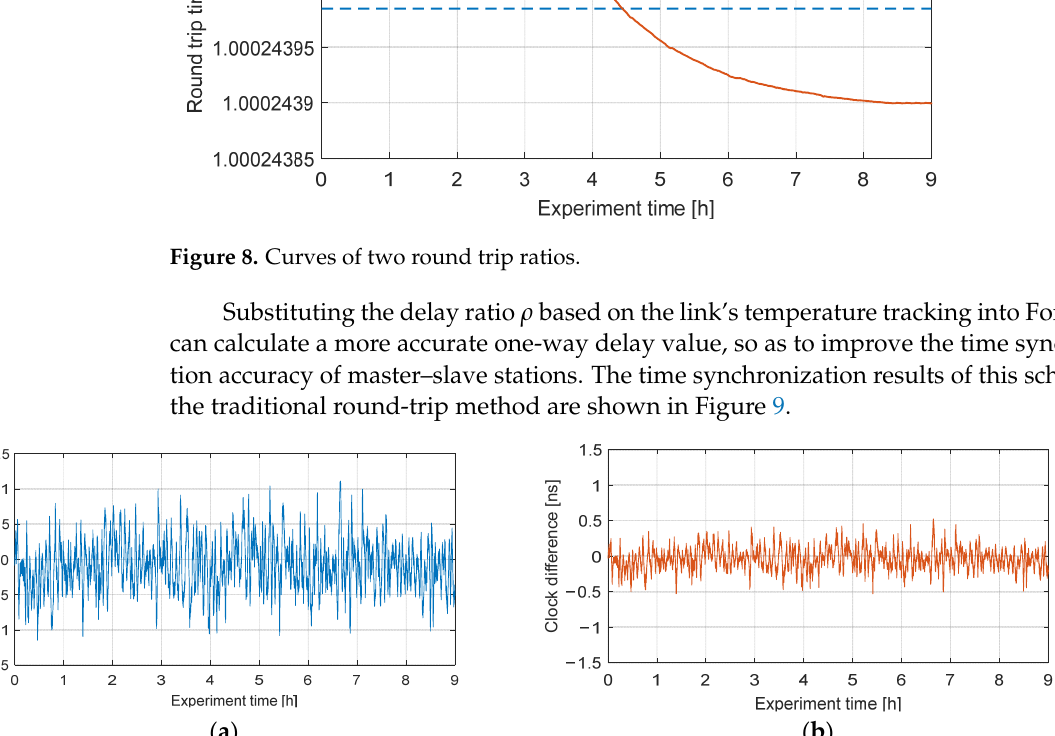
Figure 10. TDEV of two schemes. Time deviation (TDEV) is a characteristic parameter of time stability. The deteriora- tion of its short-term stability (1~100 s) is mainly related to the decline in the signal-to- noise ratio of the received signal in optical fiber transmission, whereas the deterioration of long-term stability (1000~3000 s) is mainly due to the change in the transmission delay differences of the optical fiber link with temperature and the drift of the transmission wavelength. The time stability of the round-trip method without temperature tracking is about 42 ps/s and 29 ps/10 4 s, and the time stability using the temperature tracking dis- cussed in this paper is less than 35 ps/s and 8 ps/10 4 s. 4. Conclusions In this paper, a time transfer method based on the real-time average temperature tracking of optical fiber links is proposed. By accurately measuring the round-trip delay sum of the optical fiber link, and filtering out the delay jitter and system noise using the Kalman filter, the real-time average temperature of the optical fiber link can be accurately calculated. The real-time average temperature can accurately solve the round-trip time delay ratio of optical fiber, so as to further improve the time transmission accuracy of the round-trip time synchronization scheme. The experimental results show that the temper- ature measurement accuracy of this method is about 0.015 °C. Using this method, the